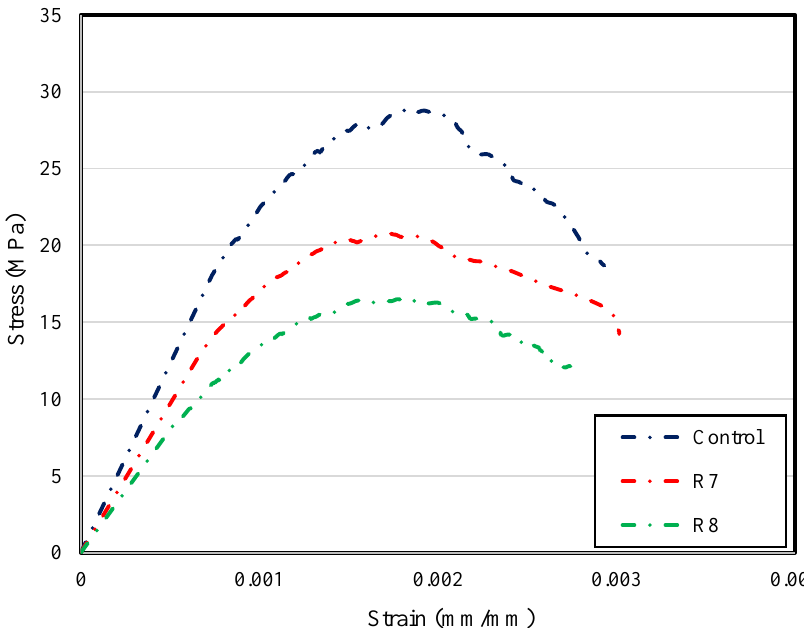
Figure 17. Comparison of the average stress-strain curves.